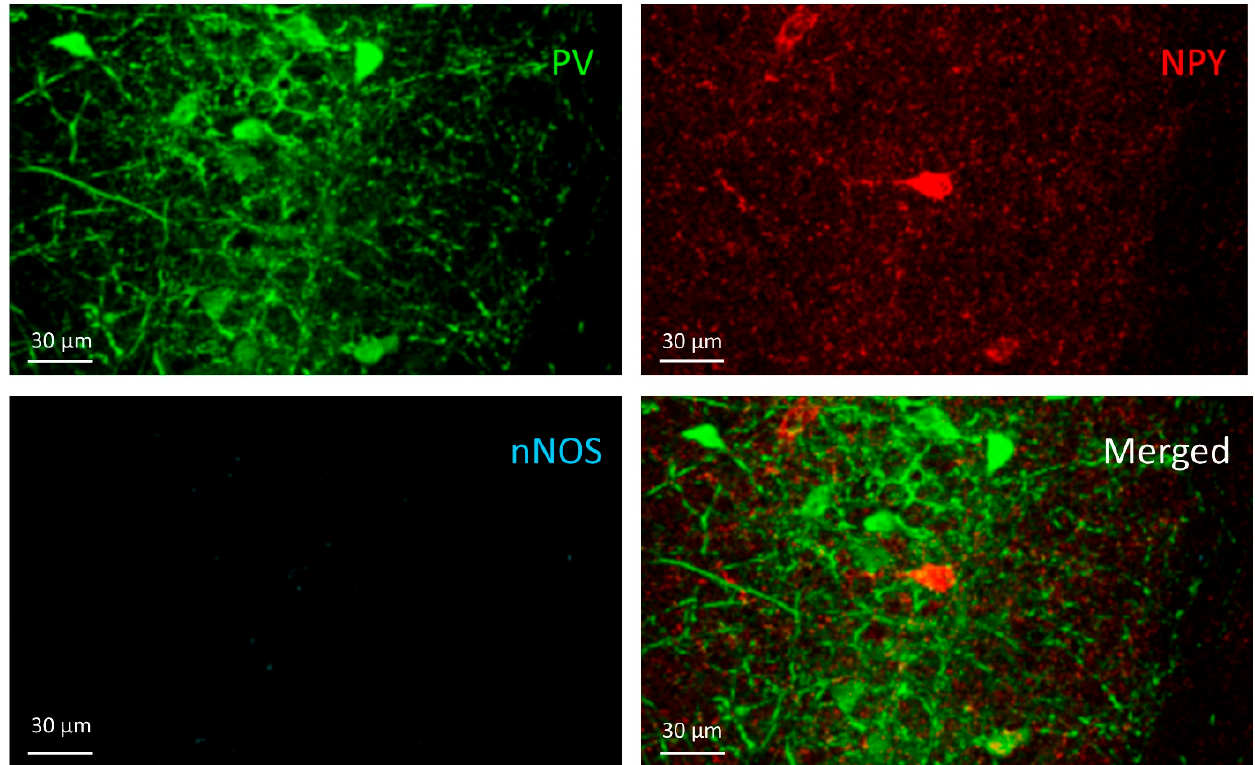
Figure 6. The NPY+ cell can be seen on the NPY channel image ( red ) in the pyramidal layer of CA1 but does not appear in the other two channels (PV and nNOS).